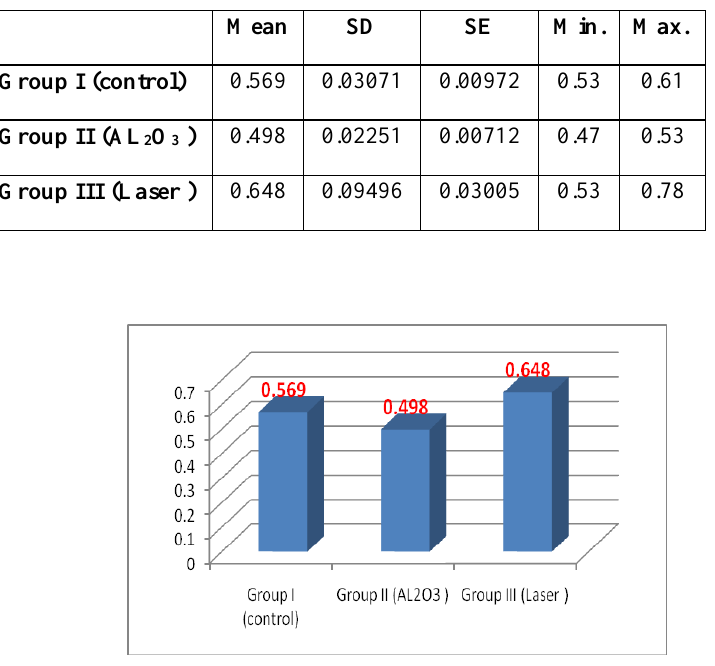
Figure 8: the shear bond strength of the soft liner in all